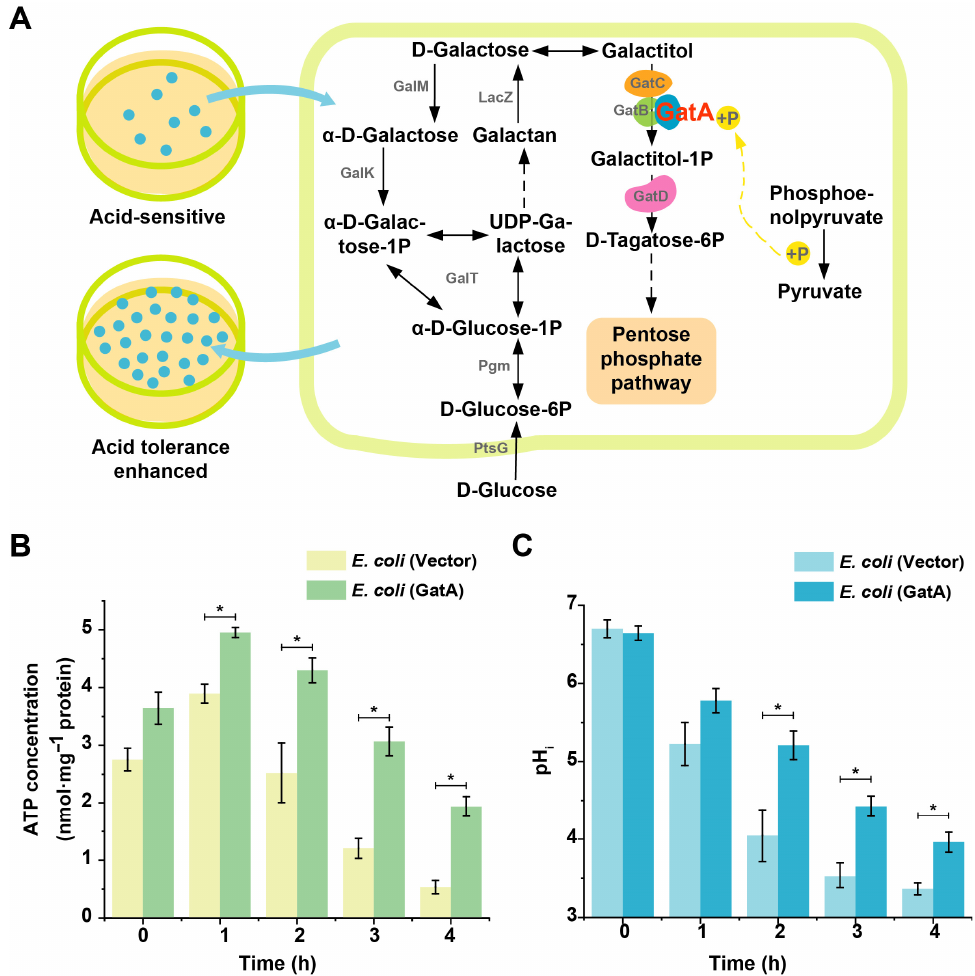
Figure 2. Overexpression of galactitol transport factor GatA enhances cell survival under D-LA lethal stress (pH 4.0) through ATP supply. ( A ) GatA is involved in the galactitol PTS pathway, the overexpression of GatA enhances cell survival number under D-LA lethal stress. ( B ) Overexpression of GatA enhances intracellular ATP of the strain against D-LA lethal stress. ( C ) Overexpression of GatA maintains intracellular pH homeostasis in strains that were incubated under lethal stress conditions of D-LA. *, p < 0.05.